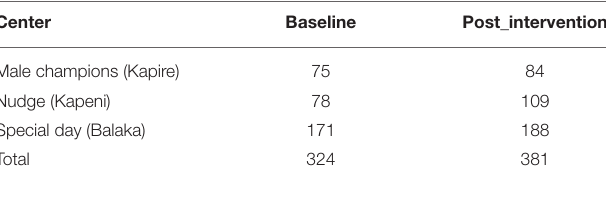
TABLE 1 | Surveys delivered per center at baseline and post-intervention.